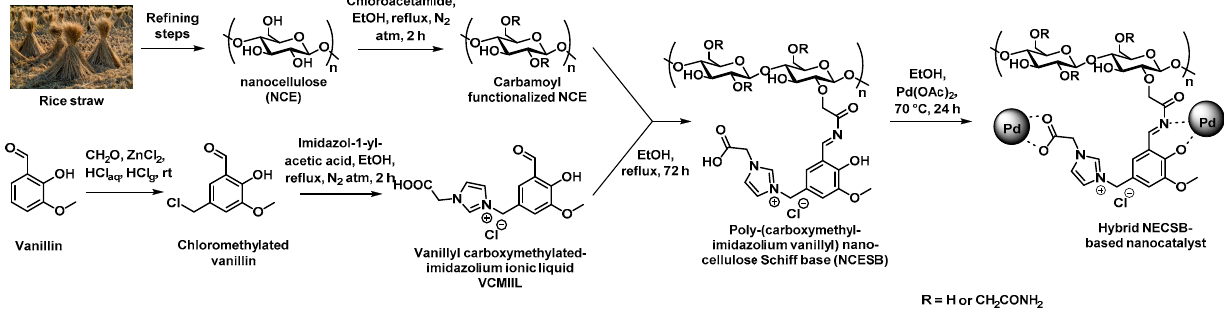
Figure 6. Synthetic procedure adopted for the preparation of supported Pd nanocatalysts from rice straw. [52]